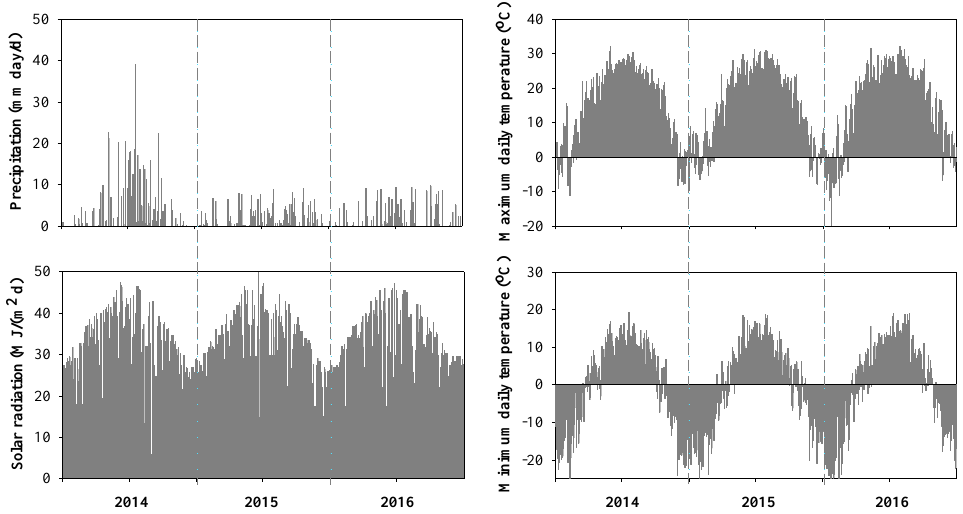
Figure 1. Daily precipitation, solar radiation, and maximum and minimum air temperature during 2014‒2016.